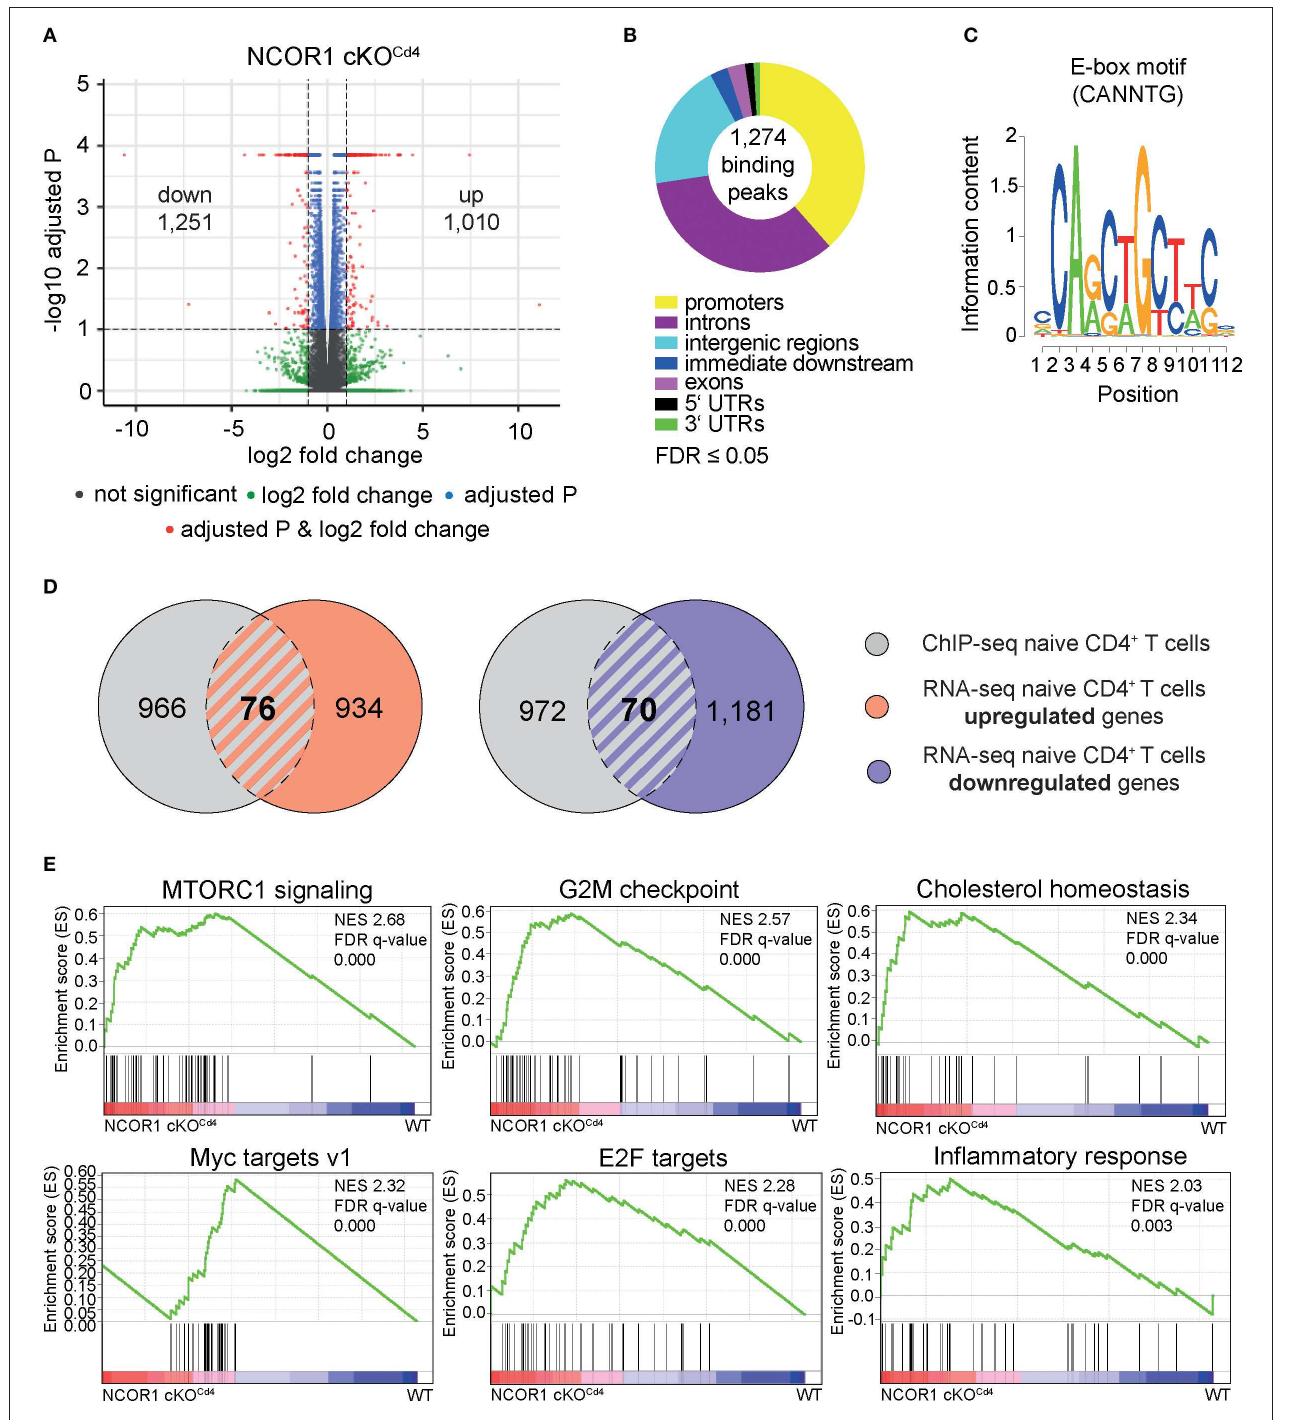
FIGURE 1 | NCOR1-dependent transcriptional profile and NCOR1 target genes in naïve CD4 + T cells. (A) RNA was isolated from naïve WT and NCOR1 cKO Cd4 CD4 + T cells and subjected to RNA sequencing. Three independent WT and NCOR1 cKO Cd4 CD4 + T cells batches were prepared on the same day. Volcano plot depicts a comparison of global gene expression profiles between naïve WT and NCOR1 cKO Cd4 CD4 + T cells. The x-axis displays fold change (log 2 ) and the y-axis indicates P -values (–log 10 ). 1,010 and 1,251 genes were up- and downregulated in NCOR1 cKO Cd4 CD4 + T cells (FDR ≤ 0.05 was used as selection criteria). (B) NCOR1 ChIP-sequencing of naïve WT CD4 + T cells revealed 1,274 significant NCOR1 binding peaks. Two independent batches were sequenced. The donut chart shows the distribution of NCOR1 binding peaks across the genome of naïve WT CD4 + T cells (promoters, introns, intergenic regions, immediate downstream, exons, 5 ′ untranslated regions (UTRs), and 3 ′ UTRs). The 1,274 binding peaks mapped to 1,042 genes, and this gene list was used for further